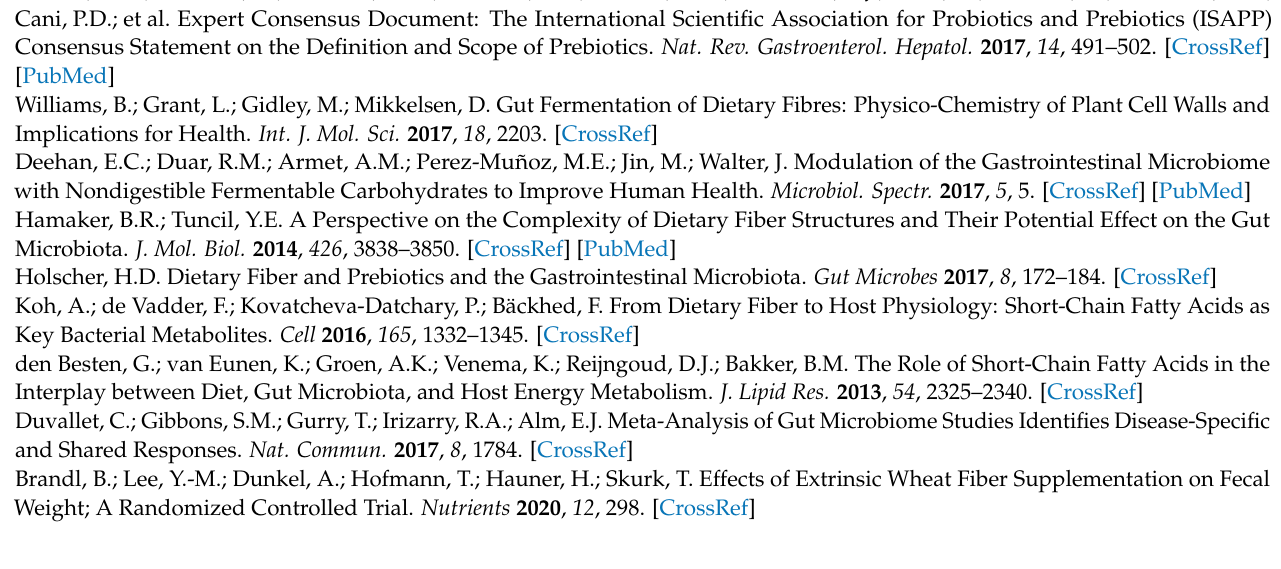
included studies. Figure S2: Risk of bias for each item assessed, presented as a percentage across all